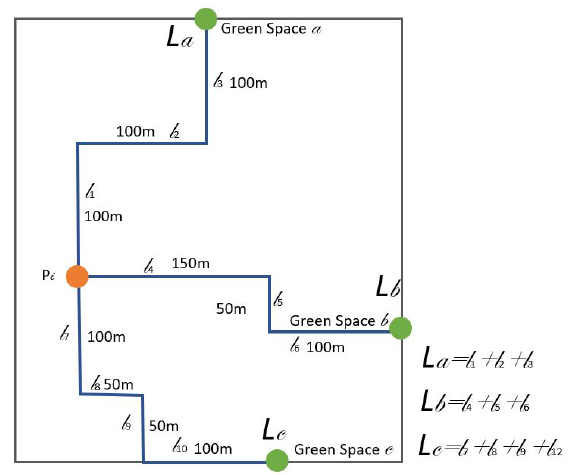
Figure 8. Travel distance calculated with travel time and speed impacted by the